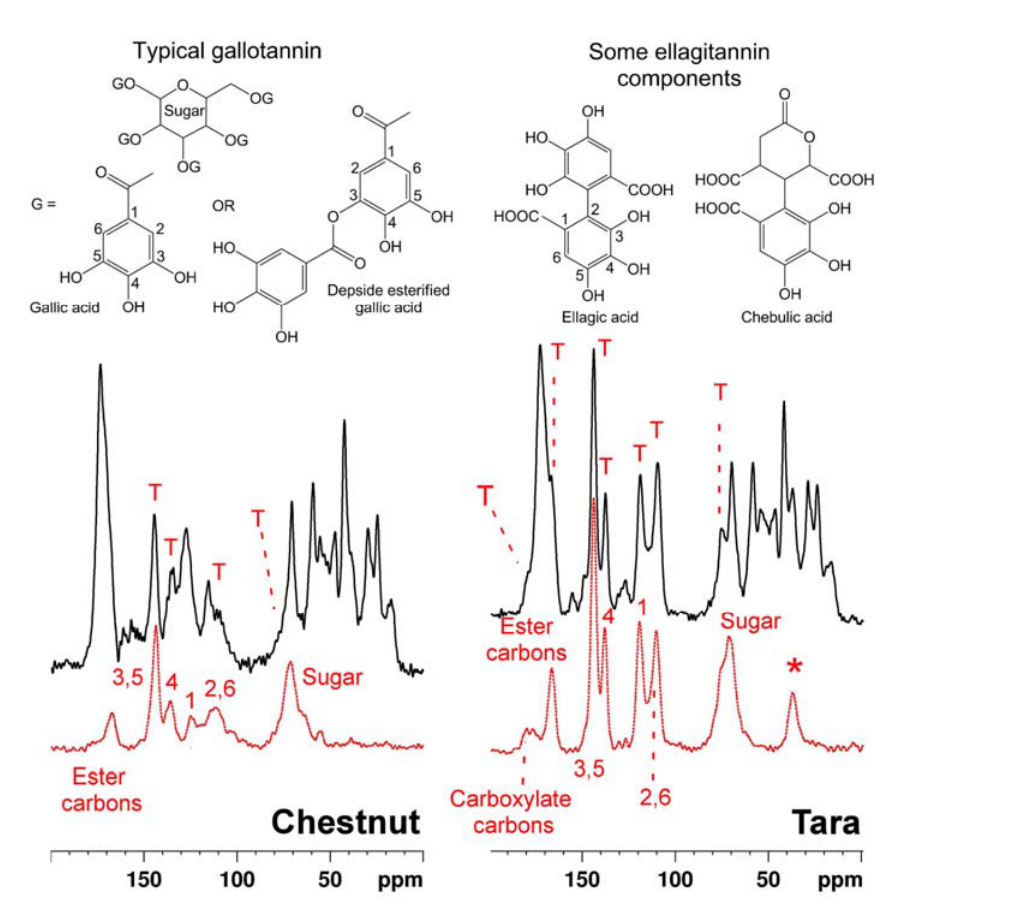
Figure 2. Solid state 13 C CP-MAS spectra of leather tanned with tannins from chestnut (left) and tara (right) (black traces) plotted above spectra of the pure tannin corresponding to the respective leather sample. Also shown are some chemical structural formulae of typical constituents of hydrolysable tannin, and spectral assignments. The asterisk (*) indicates a signal due to non-sugar sp 3 carbons in compounds such as the chebulic acid depicted